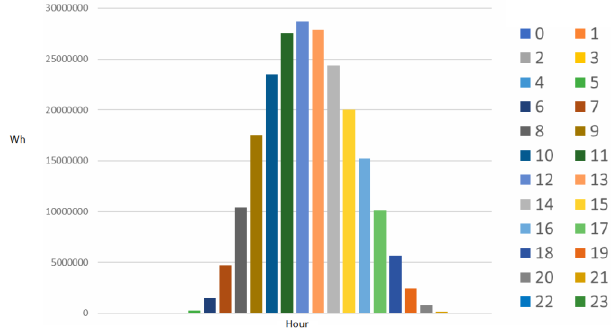
Figure 6. Monthly representation of the PV production.